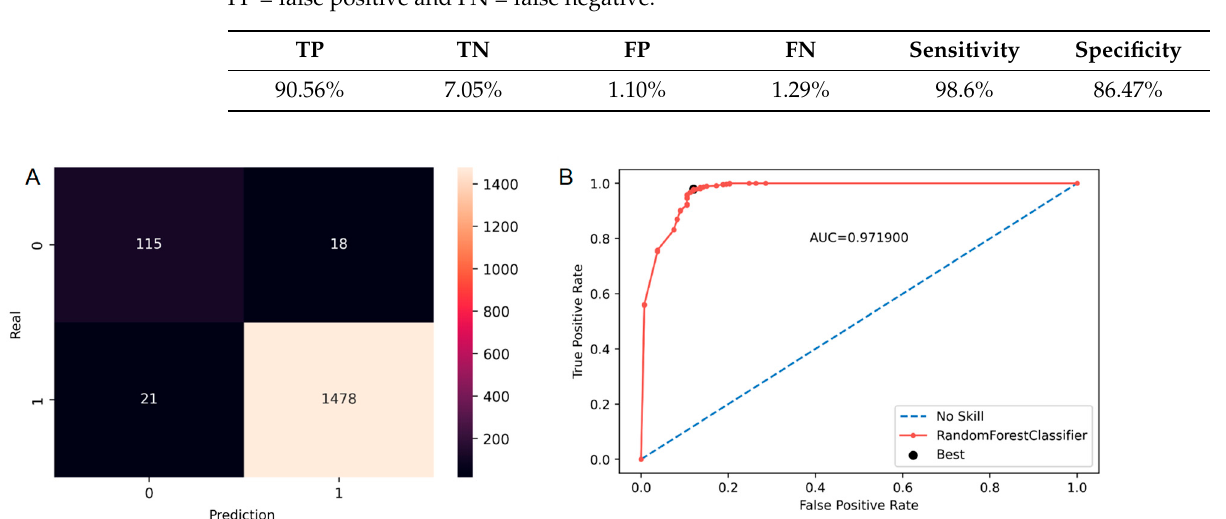
Figure 4. Confusion matrix ( A ) and ROC curve ( B ) for all tumor location ML models using Random Forest Classifier. Forest